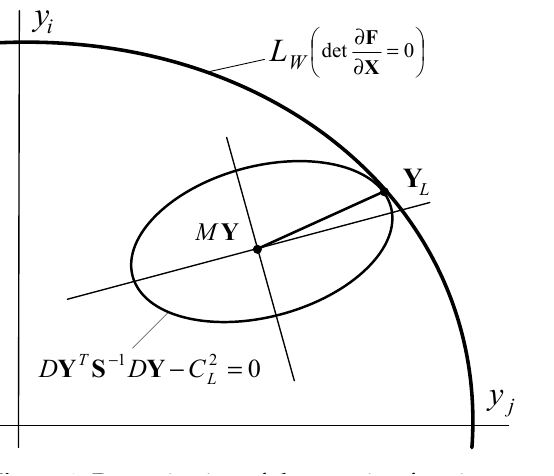
Figure 1. Determination of the margin of static aperiodic stability of electric power system in a stochastic statement.